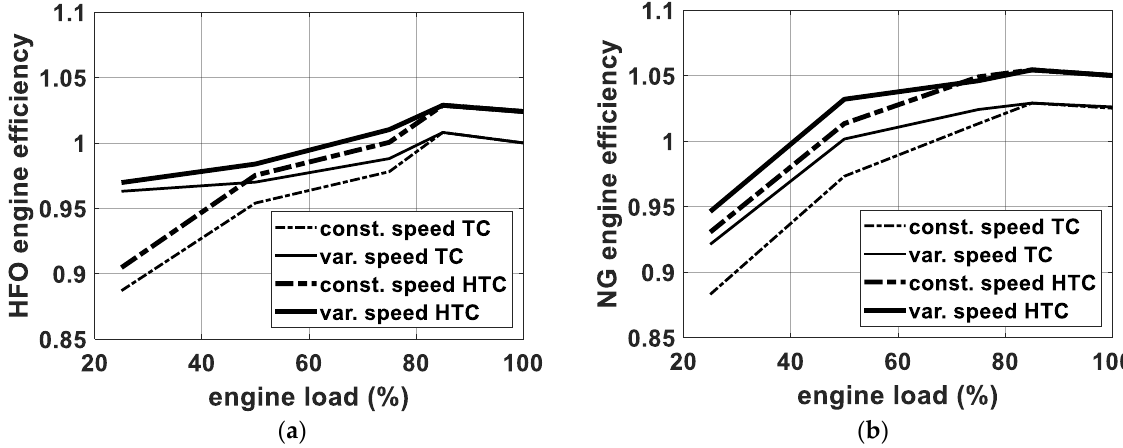
Figure 9. Normalised efficiency of the engine powered by HFO ( a ) and NG ( b ) for TC/HTC engine conditions (con- stant/variable speed).